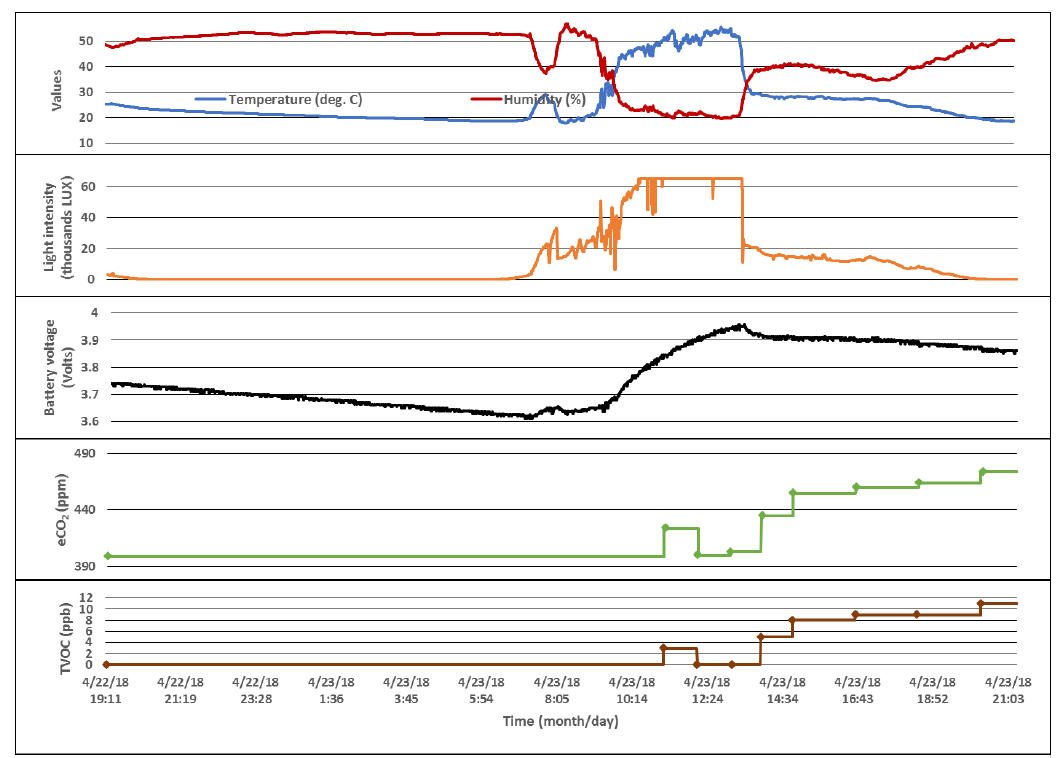
Figure 14. Data acquired by a T, RH, LUX, eCO 2 and TVOC beacon.